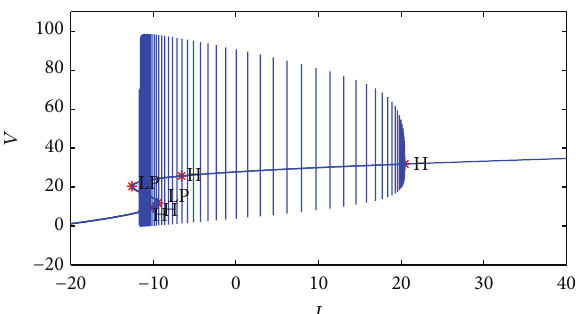
Table 1: Bifurcation analysis results derived by the Matcont soft-